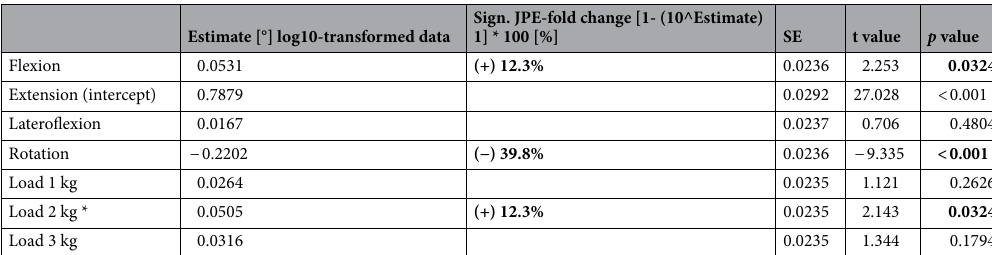
Table 3. Table of fixed effects for JPE. This table shows the fixed effects on JPE of the independent variables of cervical load and direction of movement fit through a linear mixed model with the log10-transformed estimates in degrees[°] (fixed effects), significant JPE changes and JPE-changes in percent [%], standard error and significance levels. JPE joint position error, Estimate effect size, SE standard error, NA not applicable, kg kilogram, + = increase,− = decrease, %